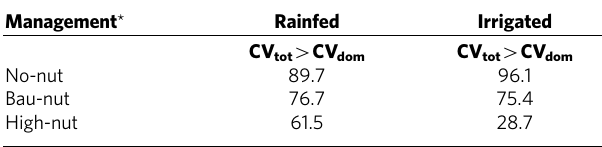
Table 1 | Percentage of grid cells with CV tot higher than CV dom